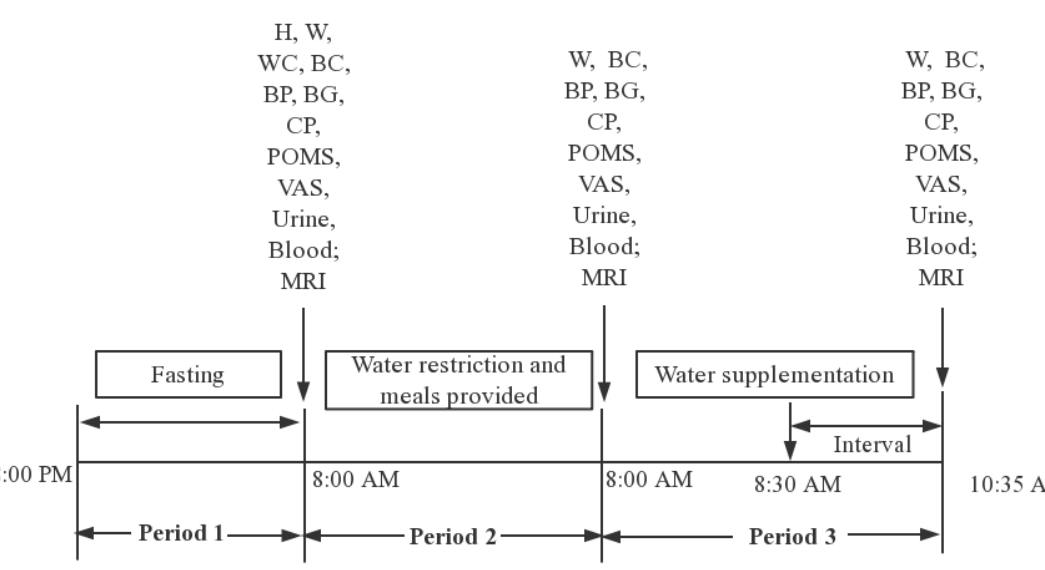
Figure 2. The study procedure (Note: H (Height); W (Weight); WC (Waist circumference); BP (Blood pressure); BG (Blood glucose); BC (Body composition); CP (Cognitive performances); POMS (Profile of Mood States); VAS (Visual Analogue Scales); MRI (Magnetic resonance imaging)).